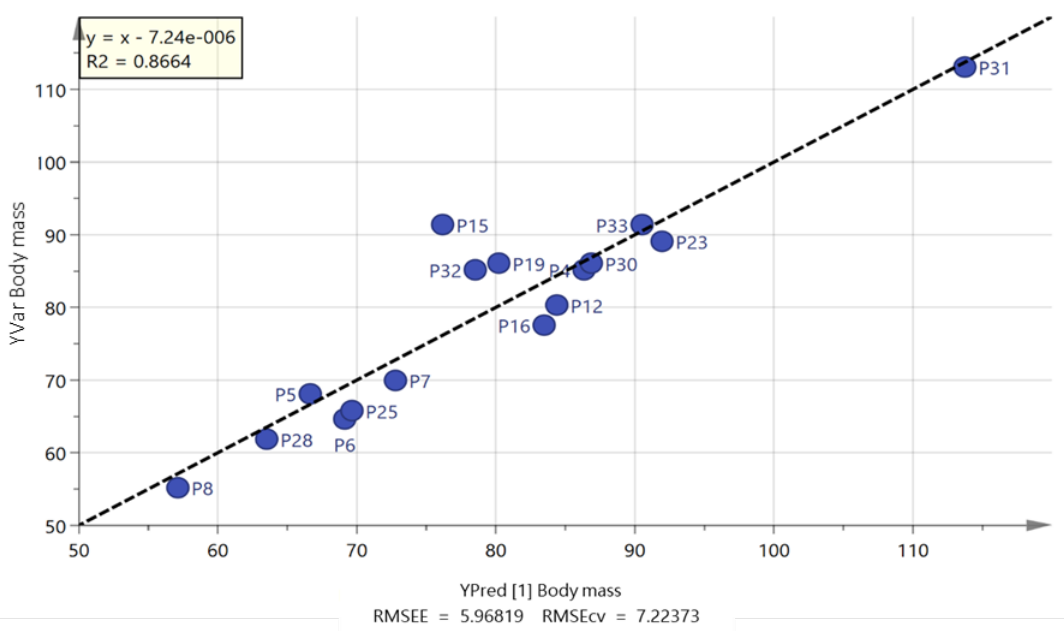
Figure 4. OPLS of predicted vs. actual body mass for South Asian men based on three free fatty acids lignoceric, docosahexenoic and stearic acid.